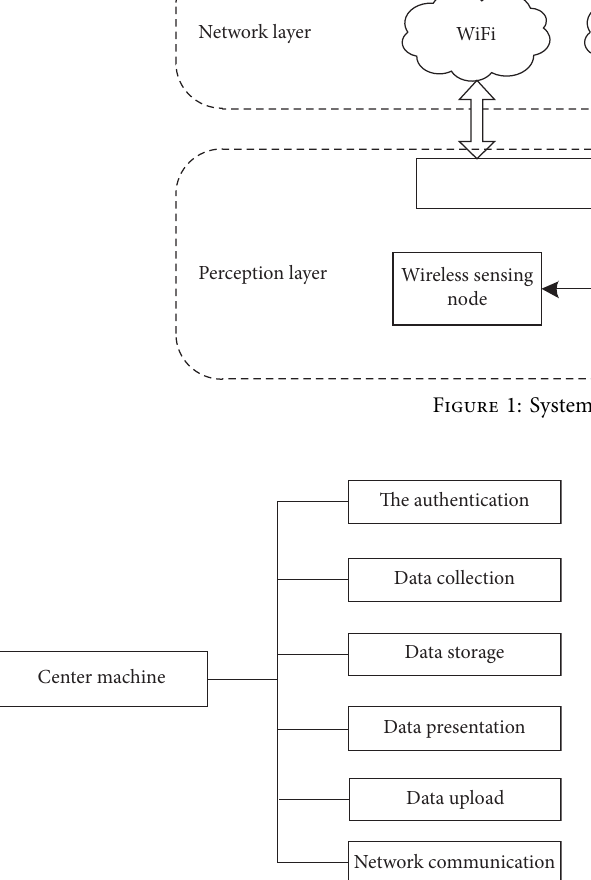
Figure 2: Functional block diagram of central